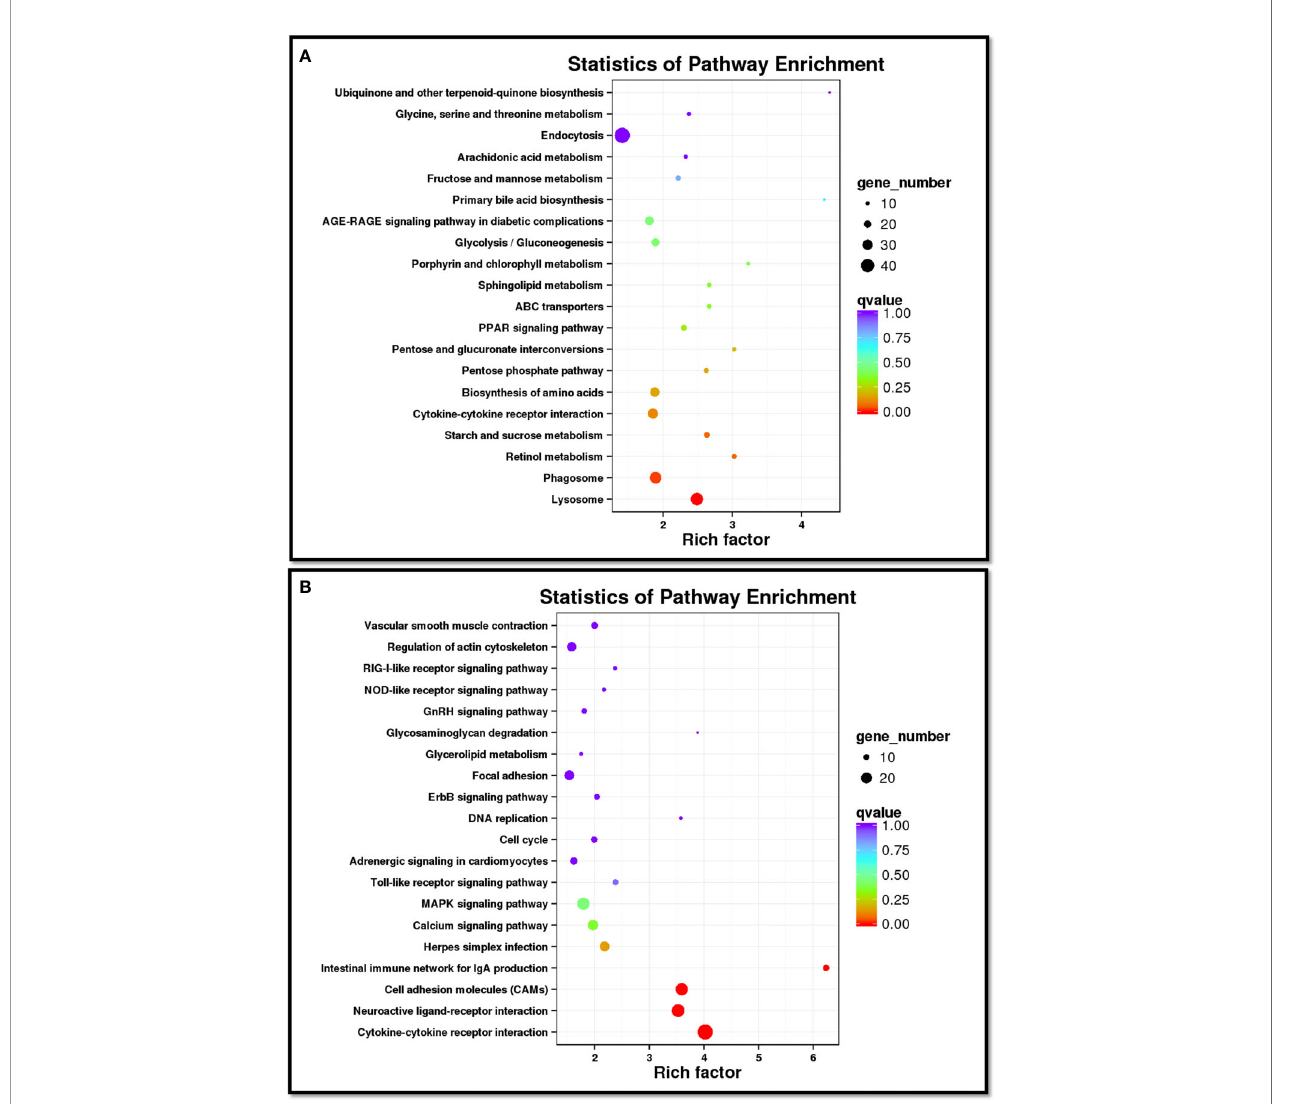
FIGURE 6 | Scatter diagram of the top 20 enriched KEGG pathways for up-regulated (A) and down-regulated (B) DEGs in diseased spleen sample. The X-axis corresponds to the rich factor of a pathway, and the rich factor is the ratio of DEGs to all the genes in a speci fi c pathway. The Y-axis represents different pathways. The magnitude of the dots displays gene number from 10 to 40 (A) or 10 to 20 (B) , and the q-value is described by the color classi fi